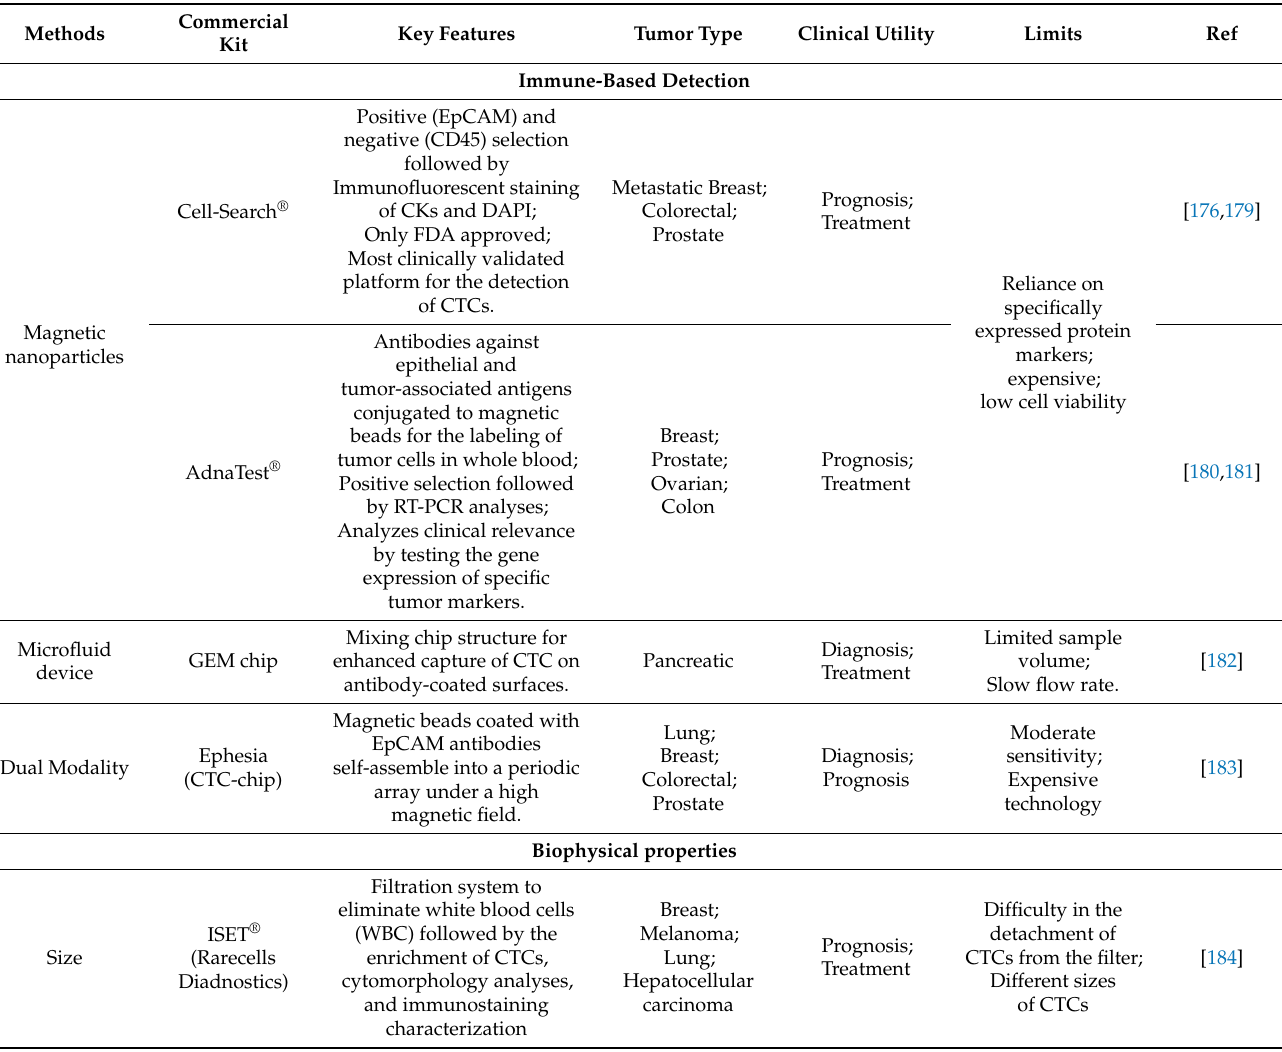
Table 1. Some commercial technologies for the detection of circulating tumor